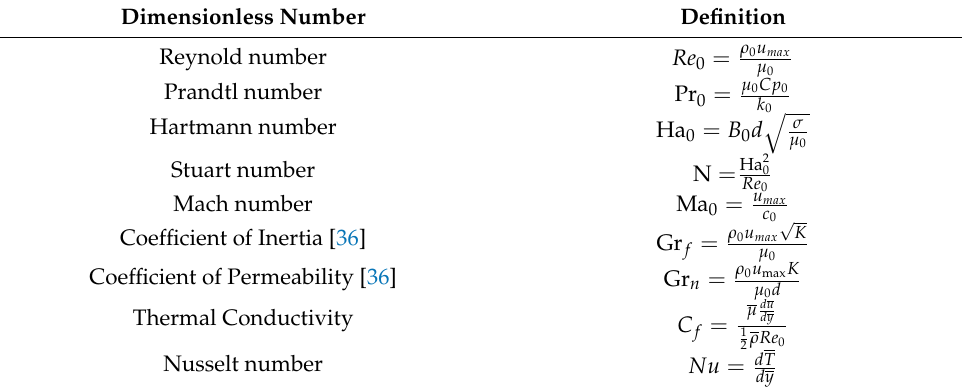
Table 2. Definition of Dimensionless